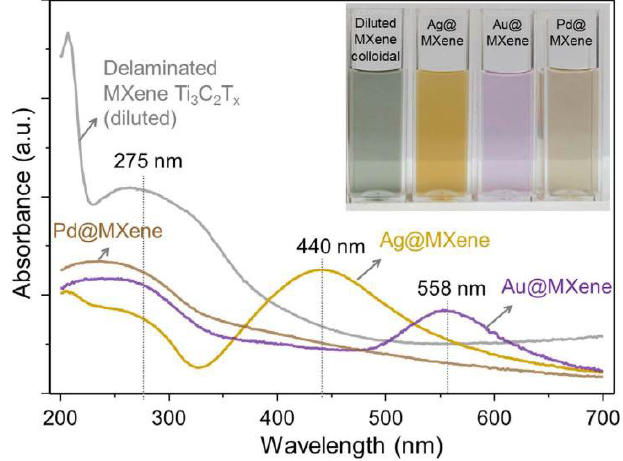
Figure 13. UV–Vis spectroscopy analysis on the delaminated Ti 3 C 2 T x nanosheets (MXene) and the colloidal suspension of MXene–metal hybrid materials. A photograph of solutions of the diluted MXene colloid, Ag, Au and Pd NPs@MXene colloids is presented in the inset (left to right, correspondingly). Reprinted with permission from [70]. Copyright 2016 Springer Nature.